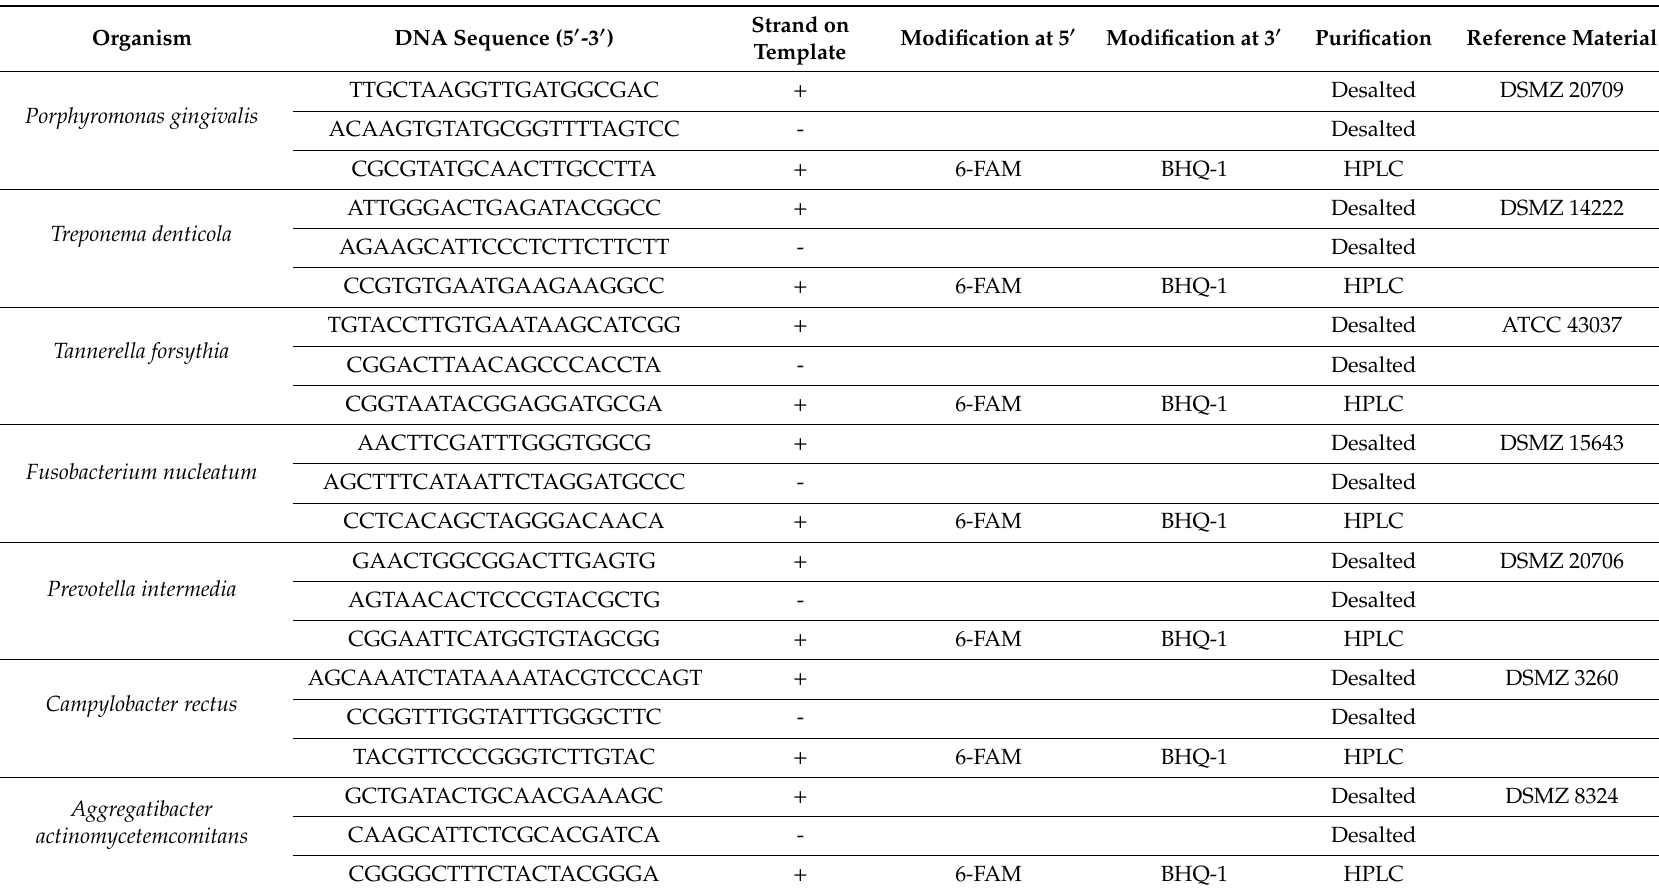
Table 1. Representation of designed oligonucleotide sets used for the detection of target bacteria. The table includes primer and probe sequences,